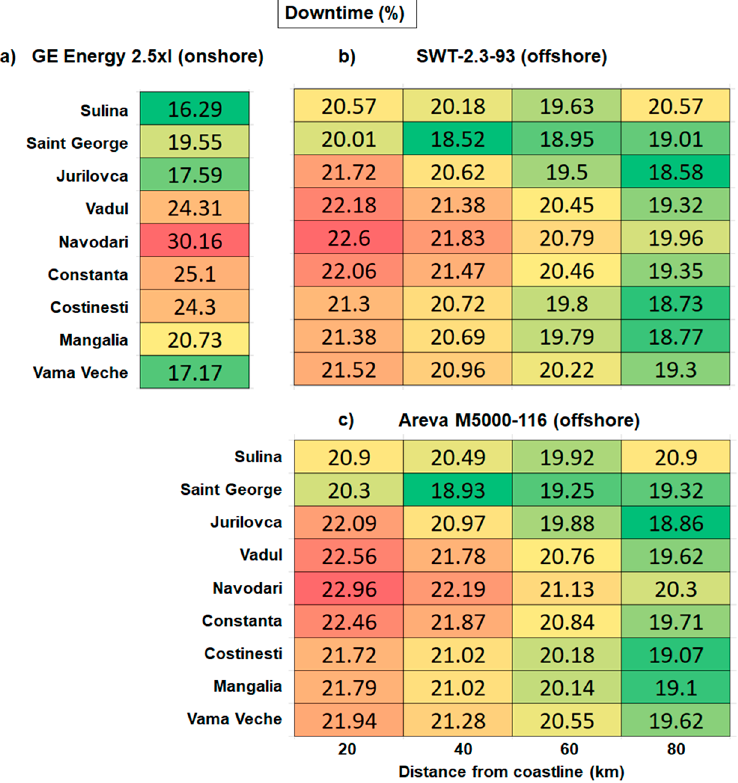
Figure 6. Downtime period of the wind turbines (%), considering the wind values located below the cut-in speed of: ( a ) GE Energy 2.5xl; ( b ) SWT-2.3-93; ( c ) Areva M5000-116.